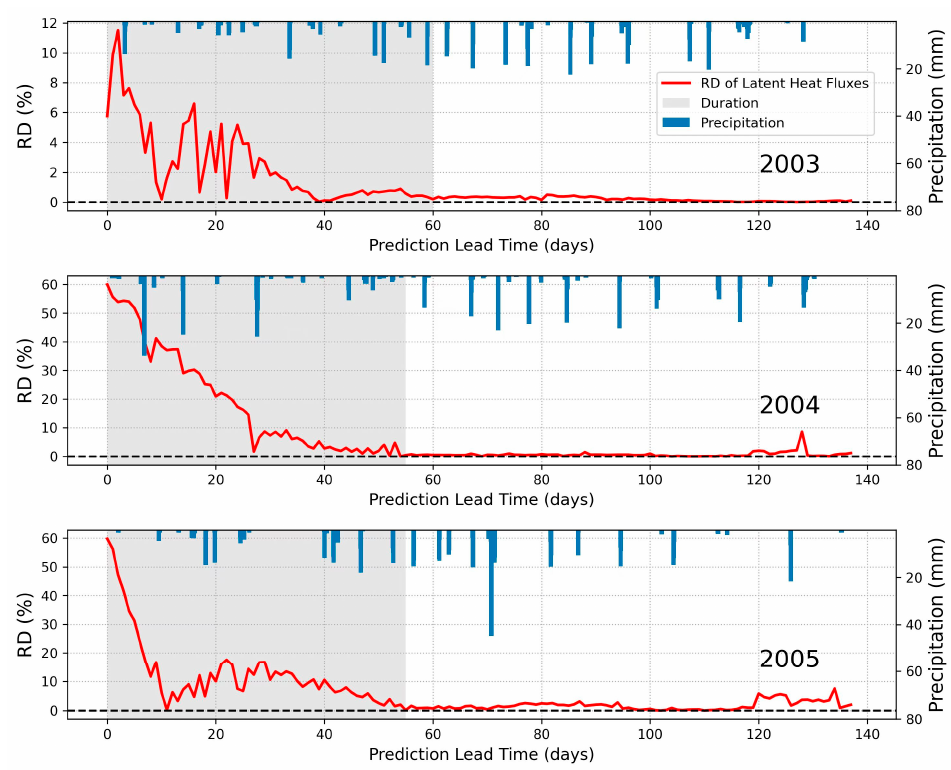
Figure 9. RD between OL and MLDAS of latent heat flux prediction in scenario I in 2003, 2004, and 2005. The shaded area represents the duration of influence brought by assimilation on future predictions.